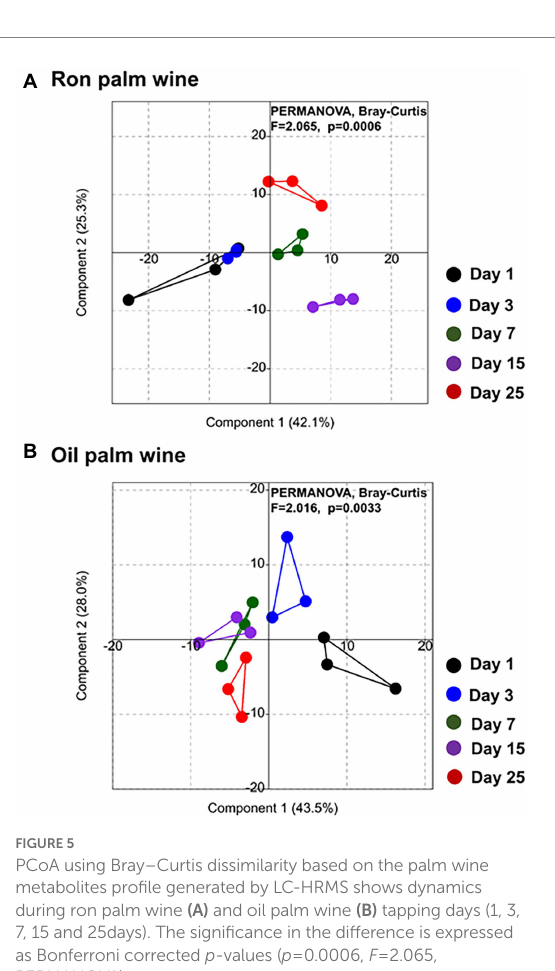
FIGURE 5 PCoA using Bray–Curtis dissimilarity based on the palm wine metabolites profile generated by LC-HRMS shows dynamics during ron palm wine (A) and oil palm wine (B) tapping days (1, 3, 7, 15 and 25 days). The significance in the difference is expressed as Bonferroni corrected p -values ( p = 0.0006, F = 2.065,